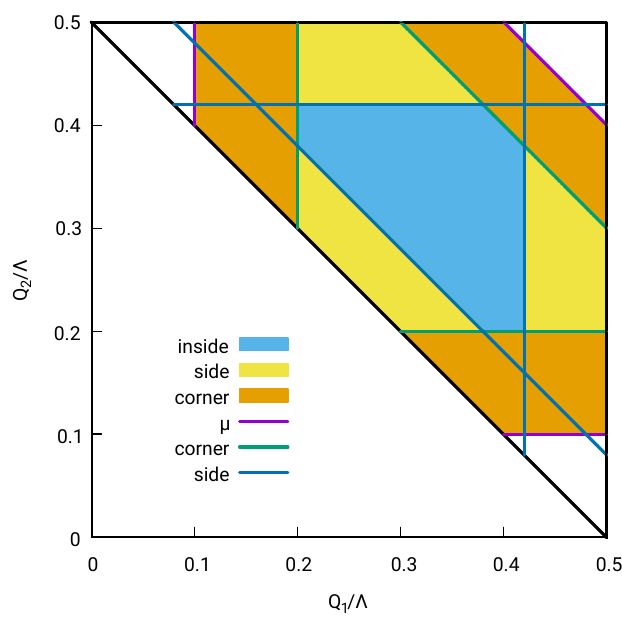
Figure 5 . Different regions to consider in order to deal with the singularities of the ˆΠ when λ → 0 . The regions are shown for Q 1 + Q 2 + Q 3 = Λ